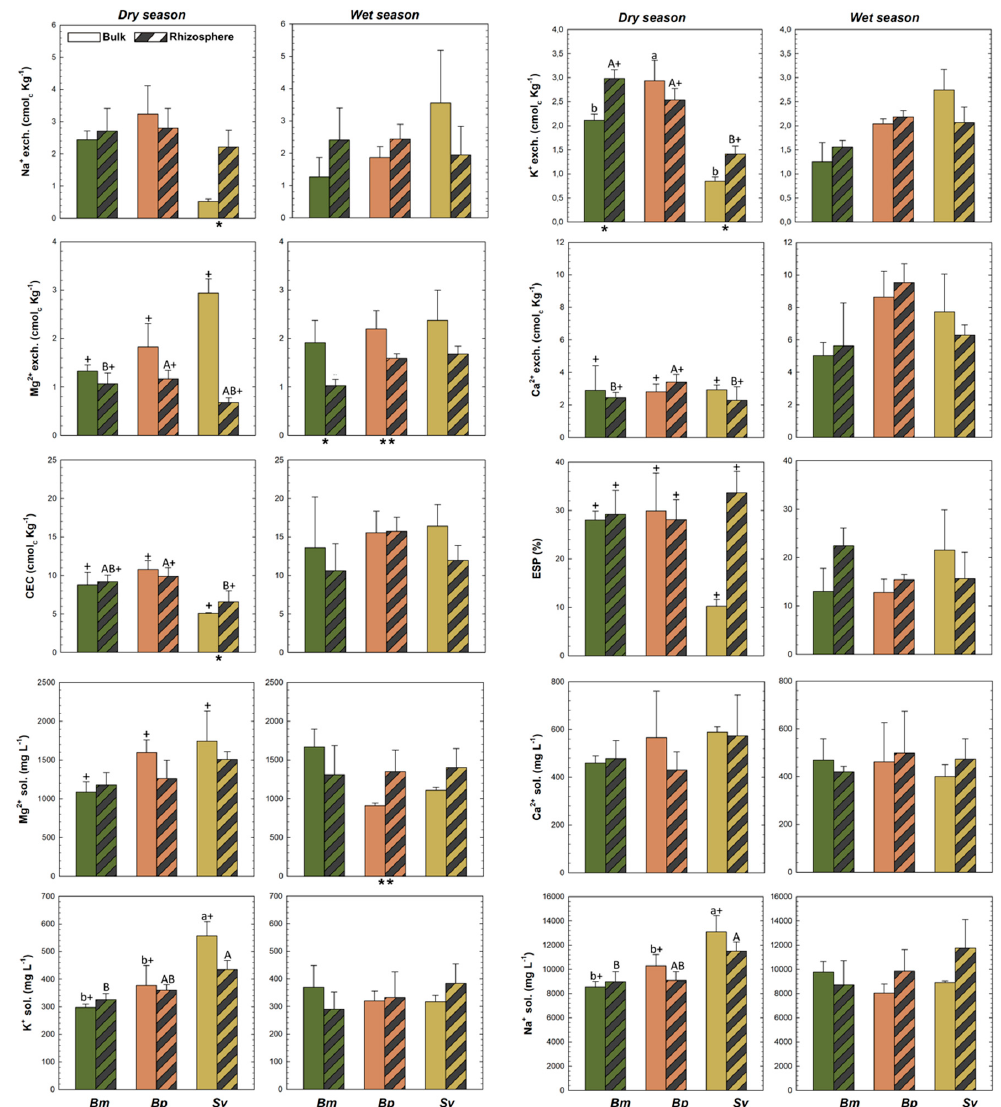
Figure 4. Soil properties for rhizosphere and bulk soils for Batis maritima (Bm), Blutaparon portulacoides (Bp), and Sporobolus virginicus (Sv) contrasted between dry and wet seasons in the hypersaline tidal flat. CEC: Cation exchangeable capacity; exch.: exchangeable; sol.: soluble. Di ff erent